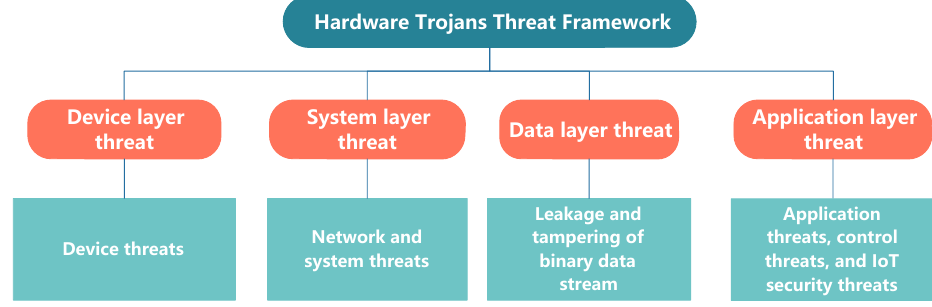
Figure 2. Definition of the HT threat framework in the respective four